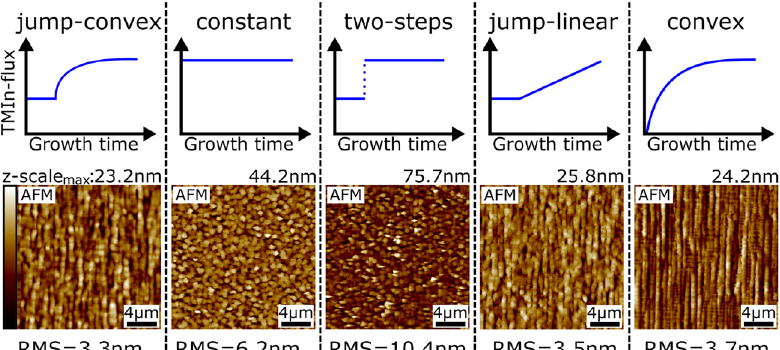
Figure 3: Optimization of growth stage II: Comparison between AFM-scans of various